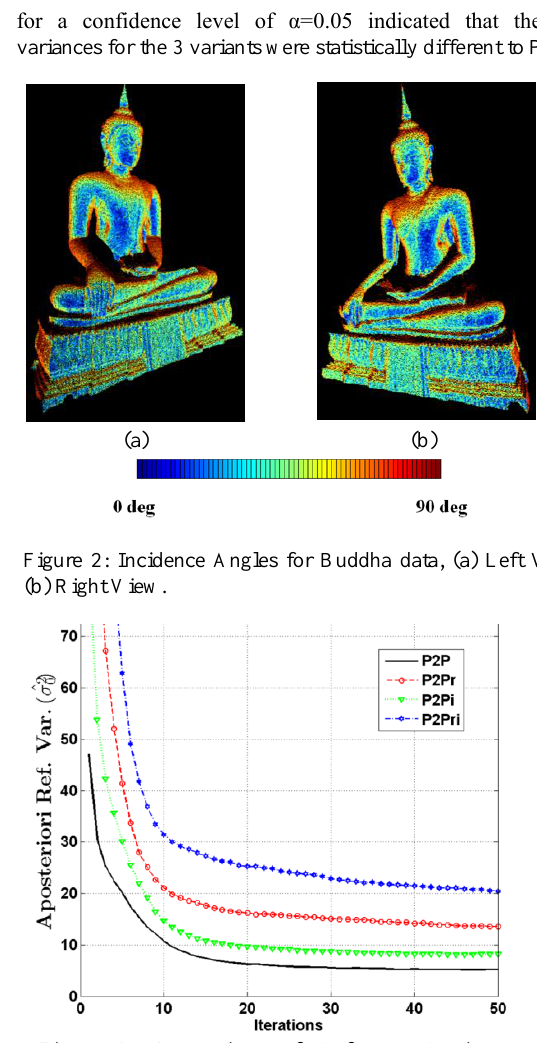
Figure 3: Comparison of Reference Variances. Values above 75 on the y-axis are not shown.